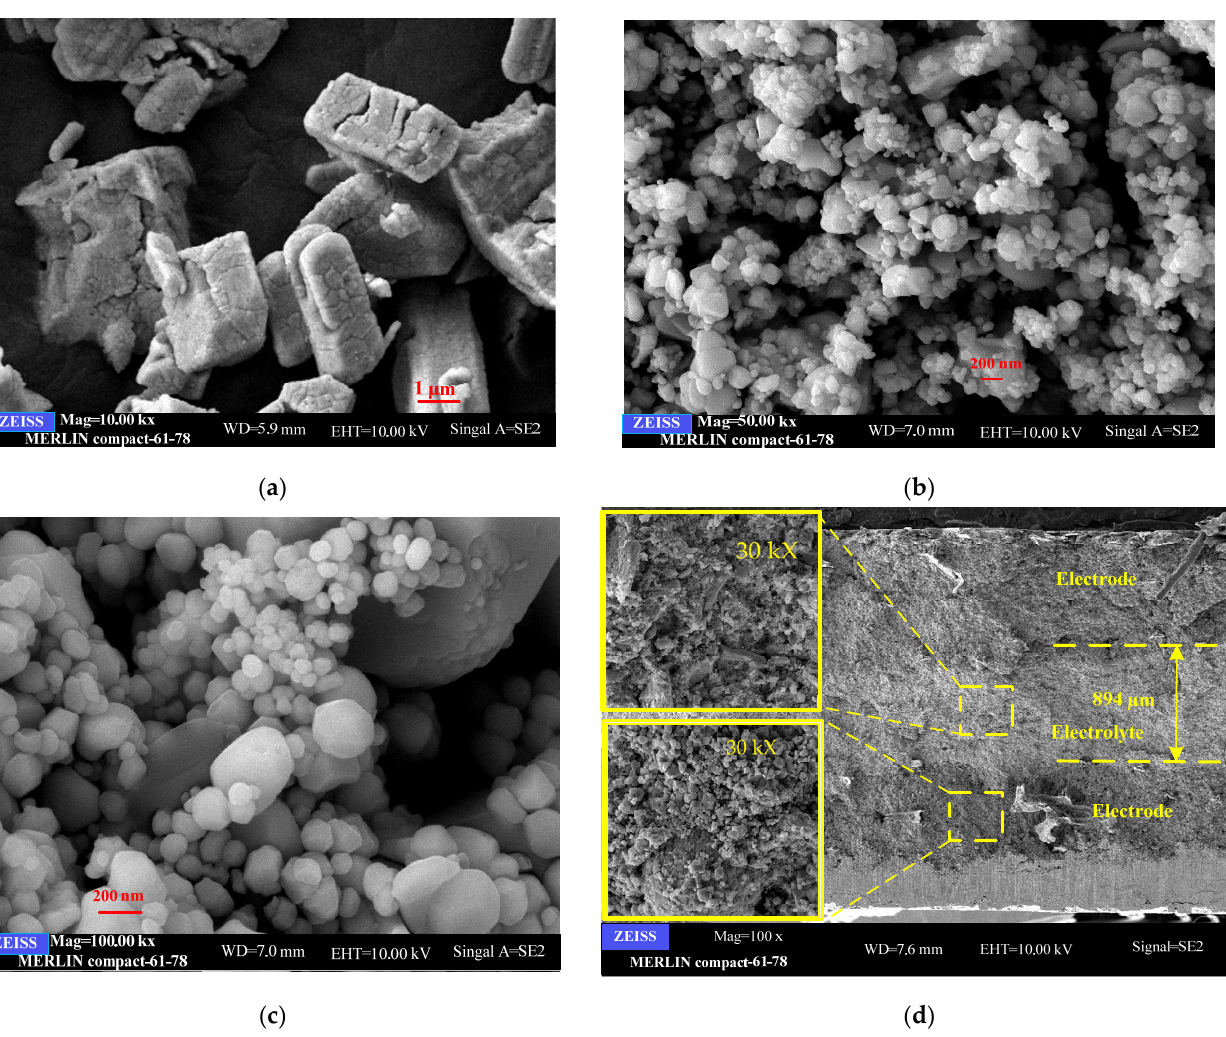
Figure 2. SEM images of ( a ) commercial CeO 2 ; ( b ) CeO 2 -NiO; ( c ) CeO 2 -Na-NiO; ( d ) the cross-sectional SEM graph of CeO 2 -Na-NiO.